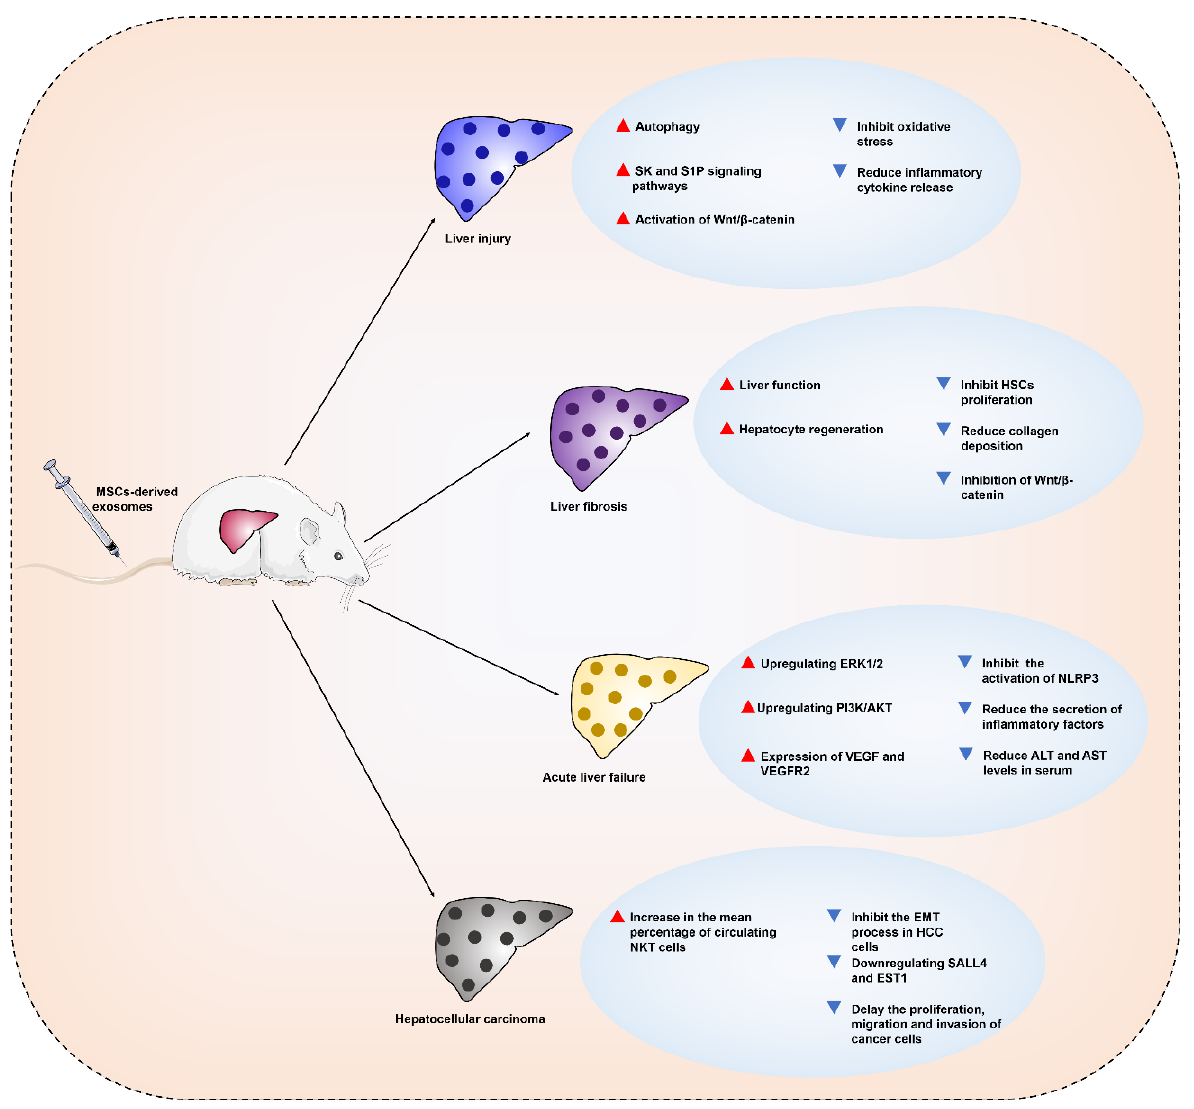
Figure 2. Pathological changes and molecular mechanisms involved in MSCs-derived exosomes in the treatment of liver diseases. Due to the different pathogenesis and pathological characteristics of various liver diseases, the main ways in which MSCs-derived exosomes exert their therapeutic effects are also different. SK: sphingosine kinase; S1P: sphingosine-1-phosphate; ERK1/2: extracellular regulated protein kinases1/2; PI3K/AKT: phosphoinositide 3-kinase/ protein kinase B; NLRP3: NOD-like receptor thermal protein domain associated protein 3; SALL4: spalt-like transcription factor 4; EST1: E26 transformation specific-1.